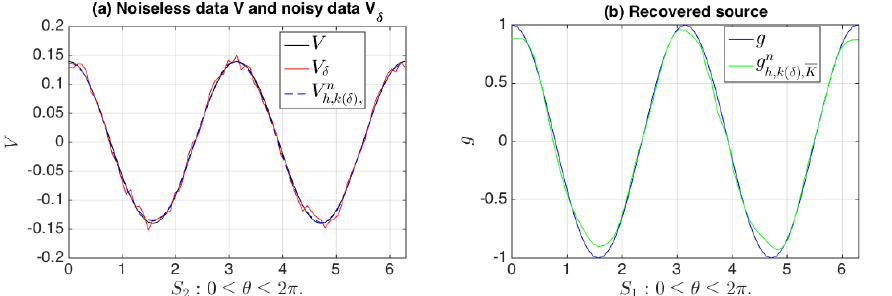
Figure 4. ( a ) Plots of exact data V (black), data with error V δ (red), and recovered data V n (blue), for δ = 0.1. ( b ) Plots of exact source g (blue) and recovered source g n corresponding to data with noise V δ , using mesh M 1 of circular region Ω .